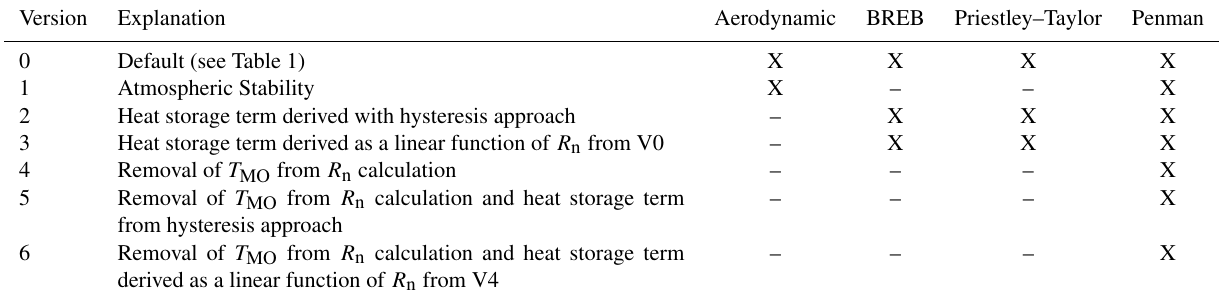
Table 2. Overview of the sensitivity studies performed for the evaporation equations. Sensitivity studies applied to a method are marked with an